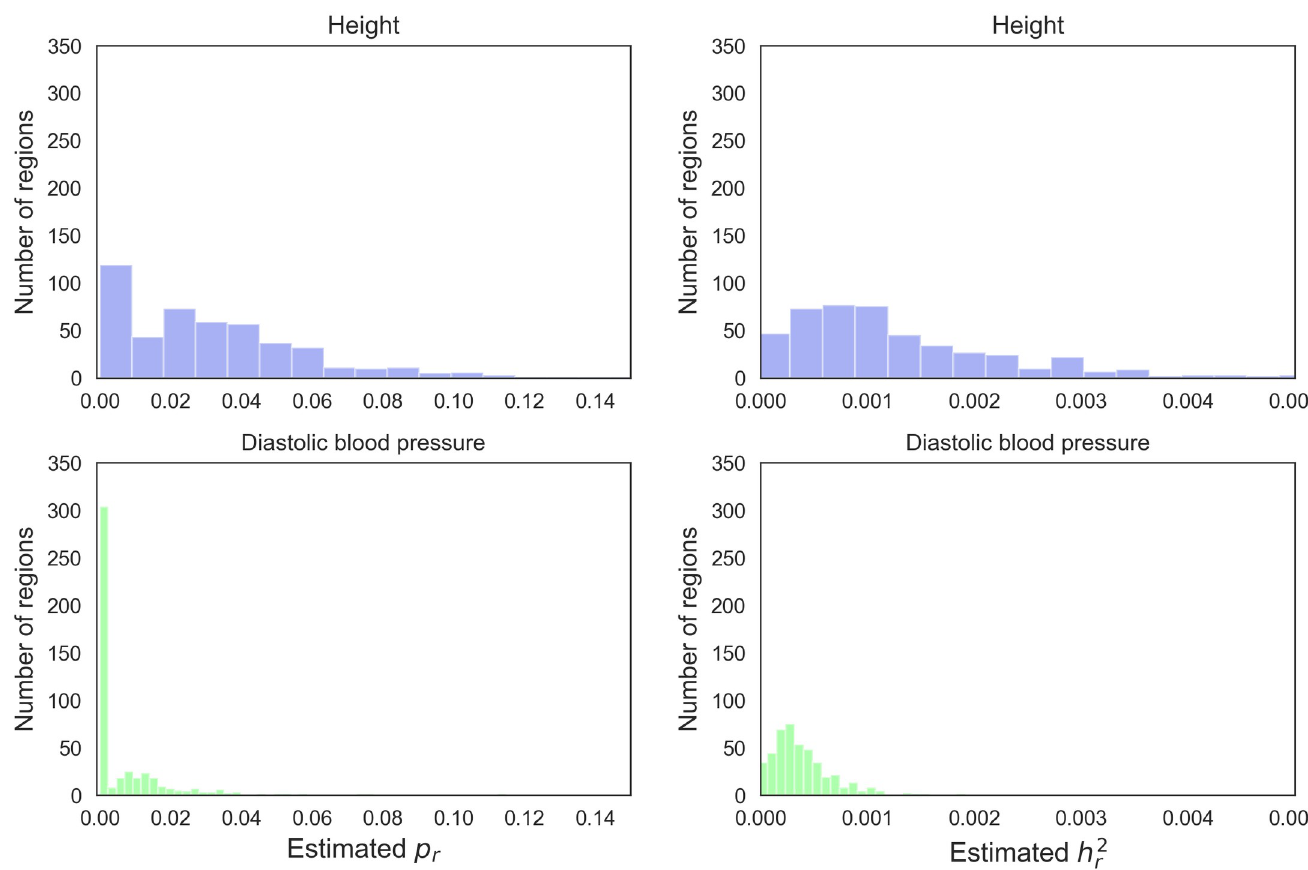
Fig 5. Distribution of regional polygenicity and heritability. We divide the genome into 6-Mb regions and report the posterior mean of the regional polygenicity for each region across height and diastolic blood pressure. Using external software [12], we report the distribution of regional heritability for each trait.